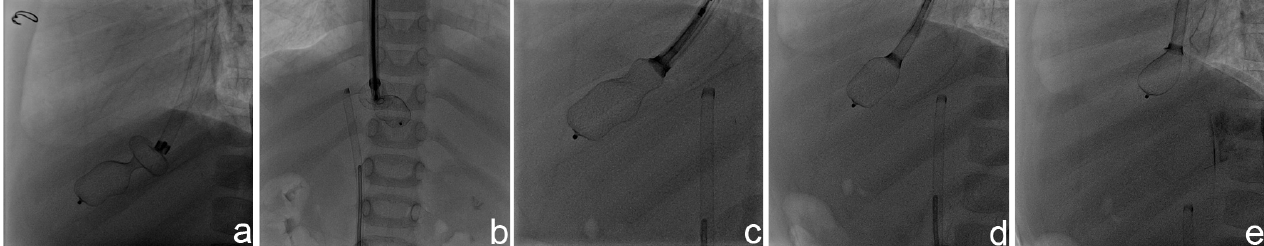
Fig. 2 - A: 14F Mullins long sheath placed over the end screw of the ASO. B and C: Telescopic system introduced to the distal tip of the ASO. D and E: ASO device retrieved into the Mullins long